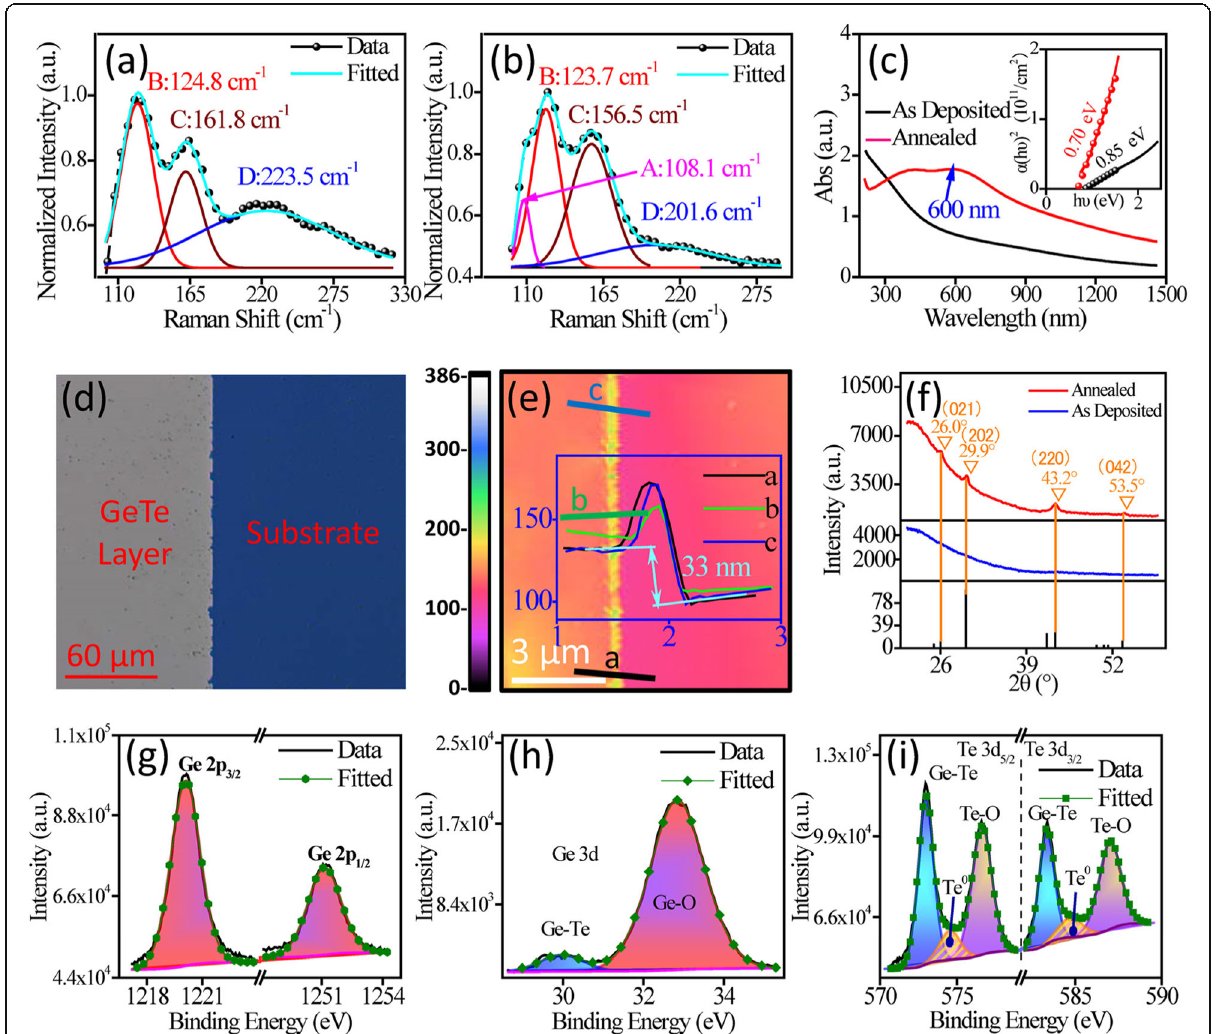
Fig. 2 a – b Normalized Raman spectra of GeTe films before and after annealing, respectively. c UV-Vis-NIR absorption spectra of the GeTe films before and after annealing. (Inset) Plot of α 2 versus photon energy ( h ν ) of the two GeTe films. d Optical images of the annealed GeTe film for AFM measurement. e AFM image and line profiles (inset) for thickness measurement of the annealed GeTe film. f XRD spectra of the GeTe films before and after annealing. g – i XPS spectra of Ge 2p, Ge 3d, and Te 3d core levels of the annealed GeTe